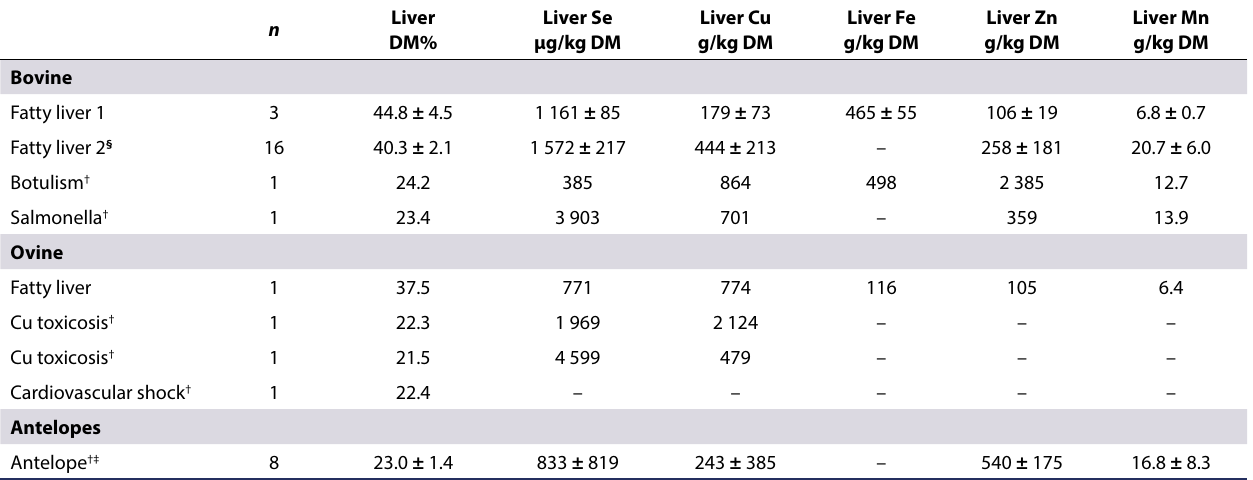
Table IV: Selected cases from UP Nutrilab data of liver dry matter (DM) levels deviating from the accepted norm, with corresponding trace element concentrations and suspected health problems, where